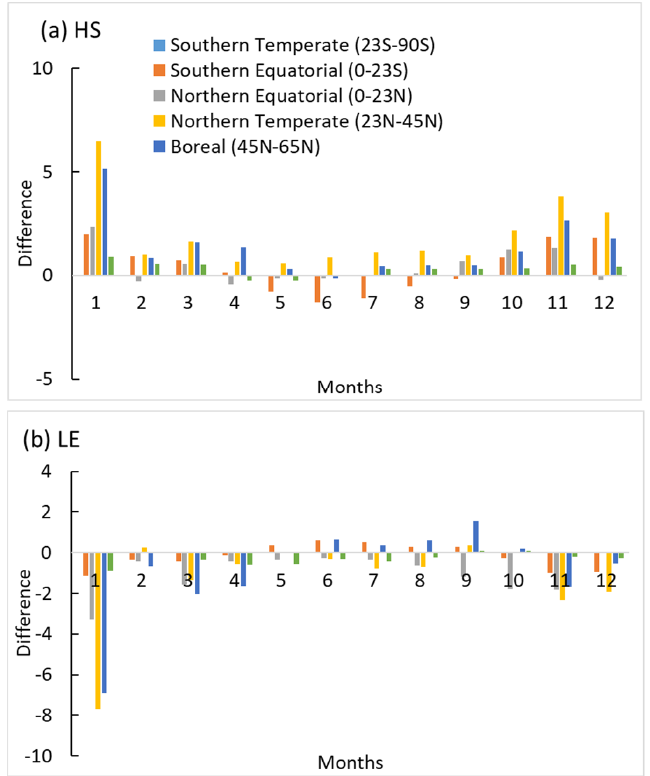
Figure 6. The zonal distribution of differences in ( a ) Hs and ( b ) Le between ESACCI and CLM_LS (W/m 2 ).